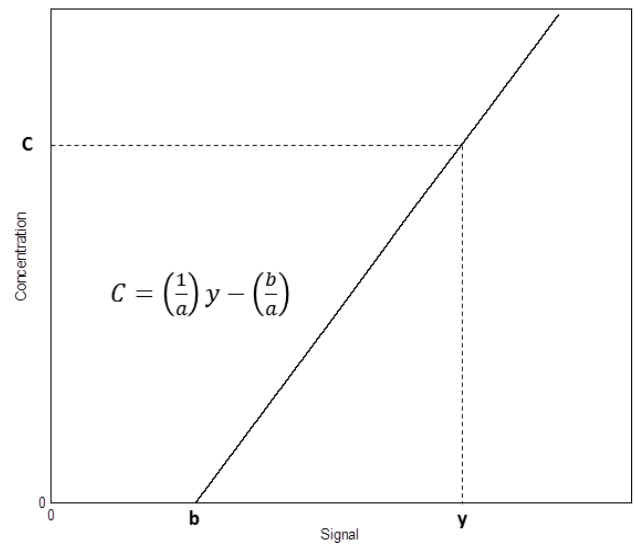
Figure 4. Concentration C versus response y through the calibration function.